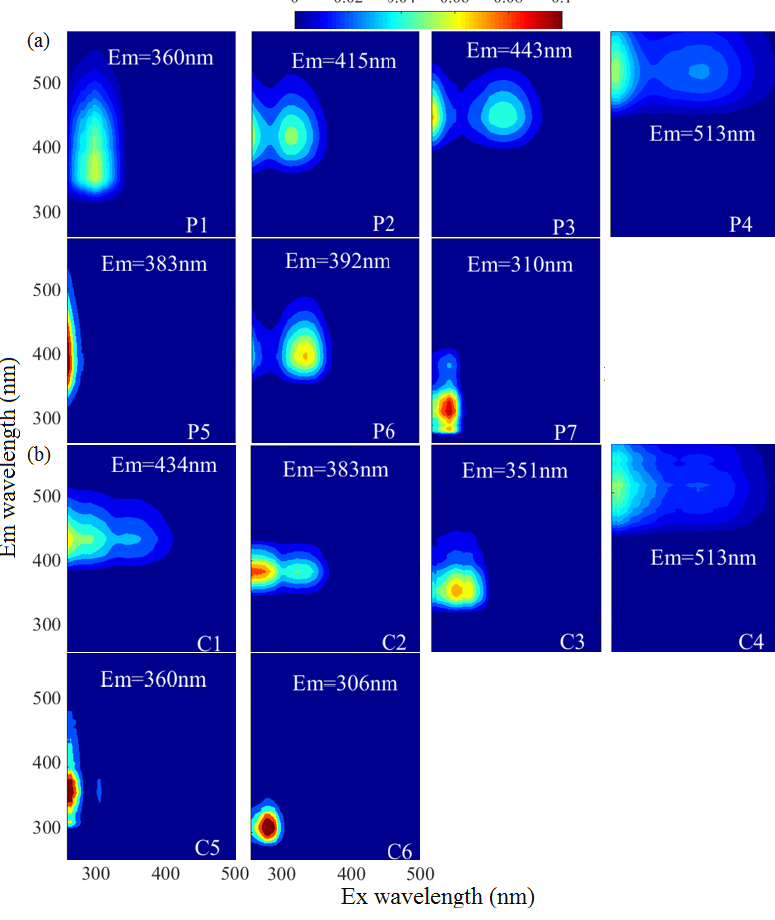
Figure 1. The fluorescent components identified by the PARAFAC (parallel factor) analysis for the EEM of water-soluble organic carbon (P1–P7, WSOC, a ) and methanol-soluble organic carbon (C1–C6, MSOC, b ) in the aerosol samples over Bangkok in Thailand ( n = 85). The color represents the fact that the intensity was normalized to set the maximum as